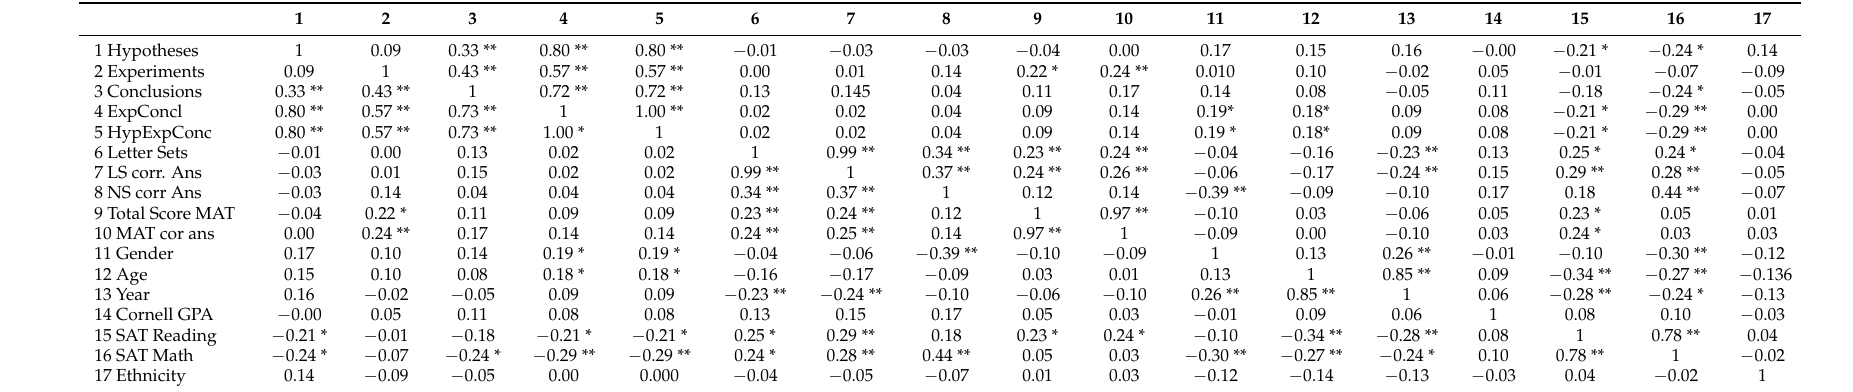
Table 2. Intercorrelations in Study